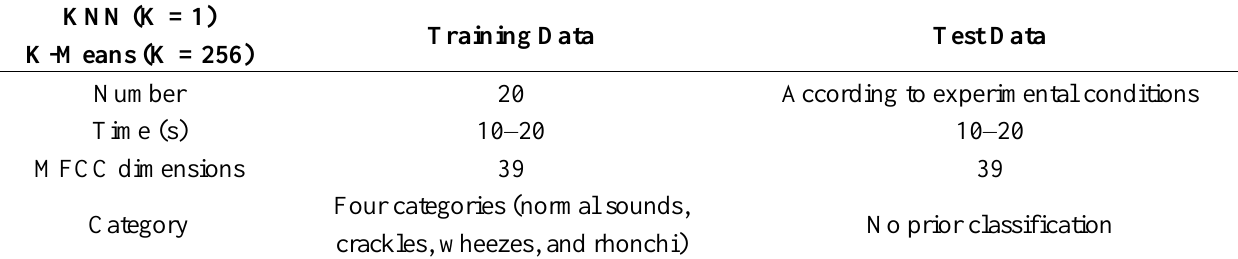
Table 2. Experimental